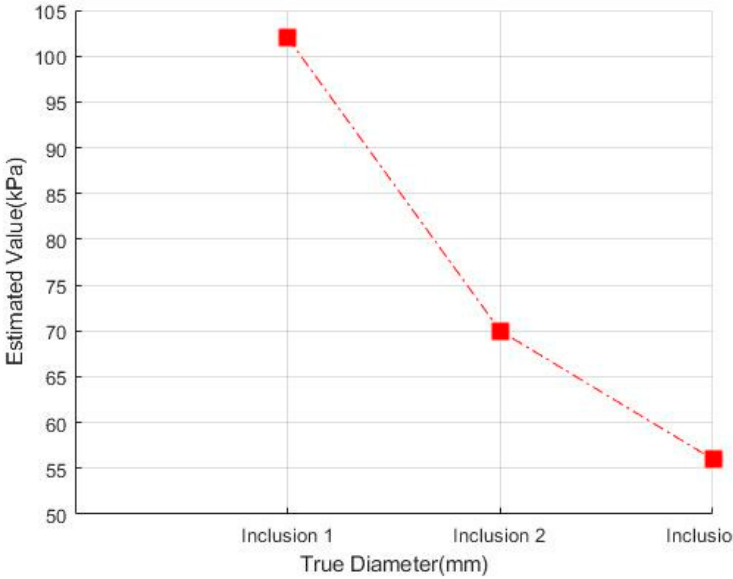
Figure 27. Z-score graph by depth.